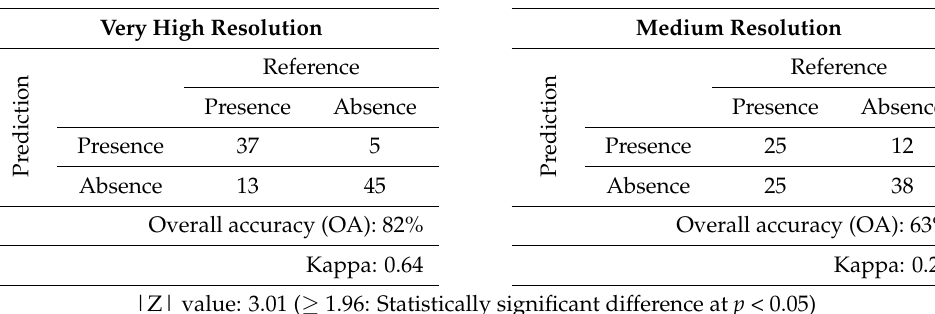
Table 5. Very-high-resolution (VHR) and medium-resolution (MR) confusion matrix obtained for the shrub growth form (blackberry).